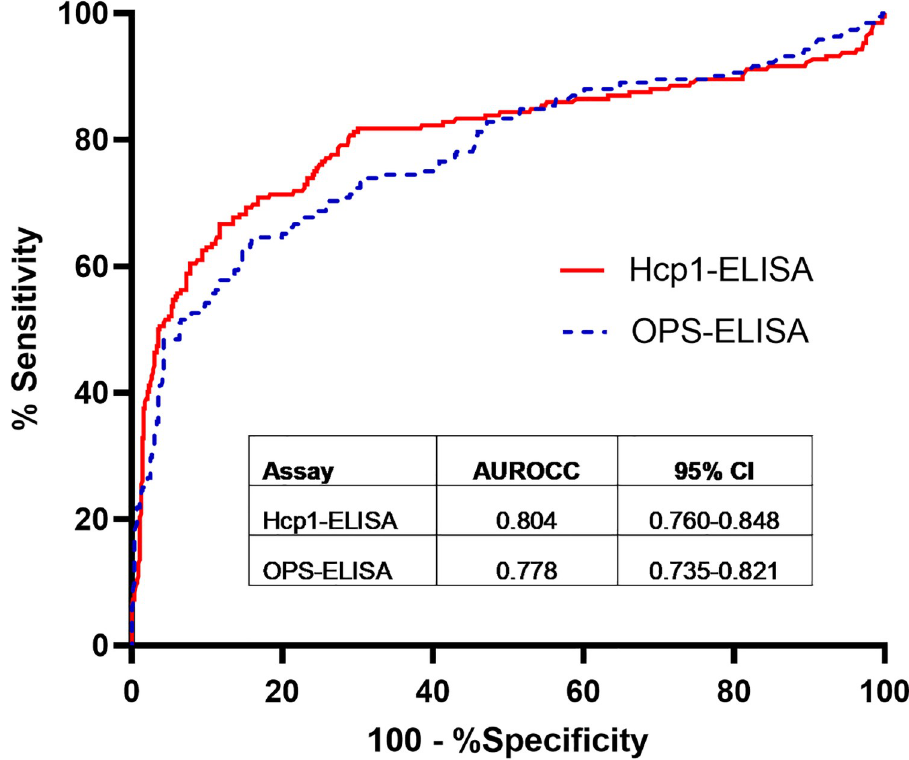
Fig 2. Receiver operating characteristic curves (ROC) plots of Hcp1-ELISA and OPS-ELISA � . � Areas under the ROC curves (AUROCC) for Hcp1-ELISA and OPS-ELISA were calculated from the optimal density (OD) from serum samples collected within 24 hours of hospital admission from culture-confirmed melioidosis cases and